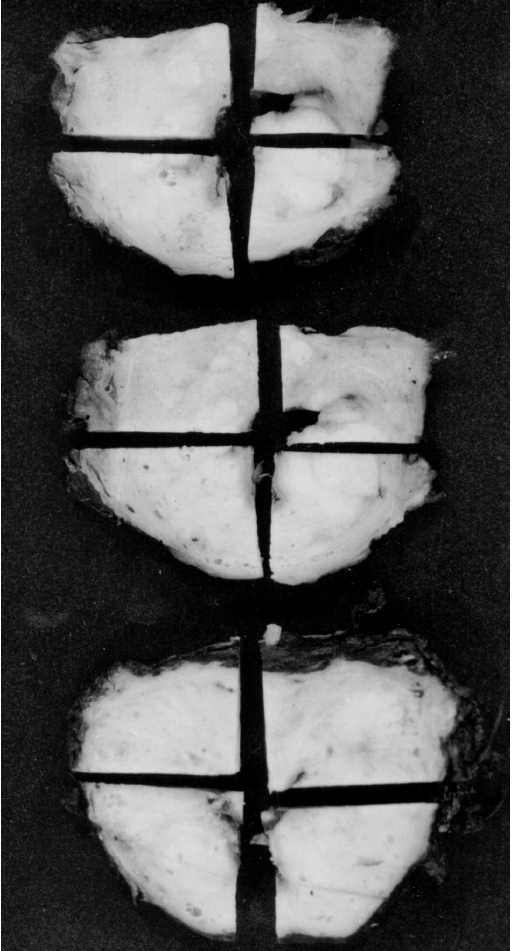
Figure 2 - The prostate slices were subdivided into quadrants and labeled to allow for reconstruction as whole-mount